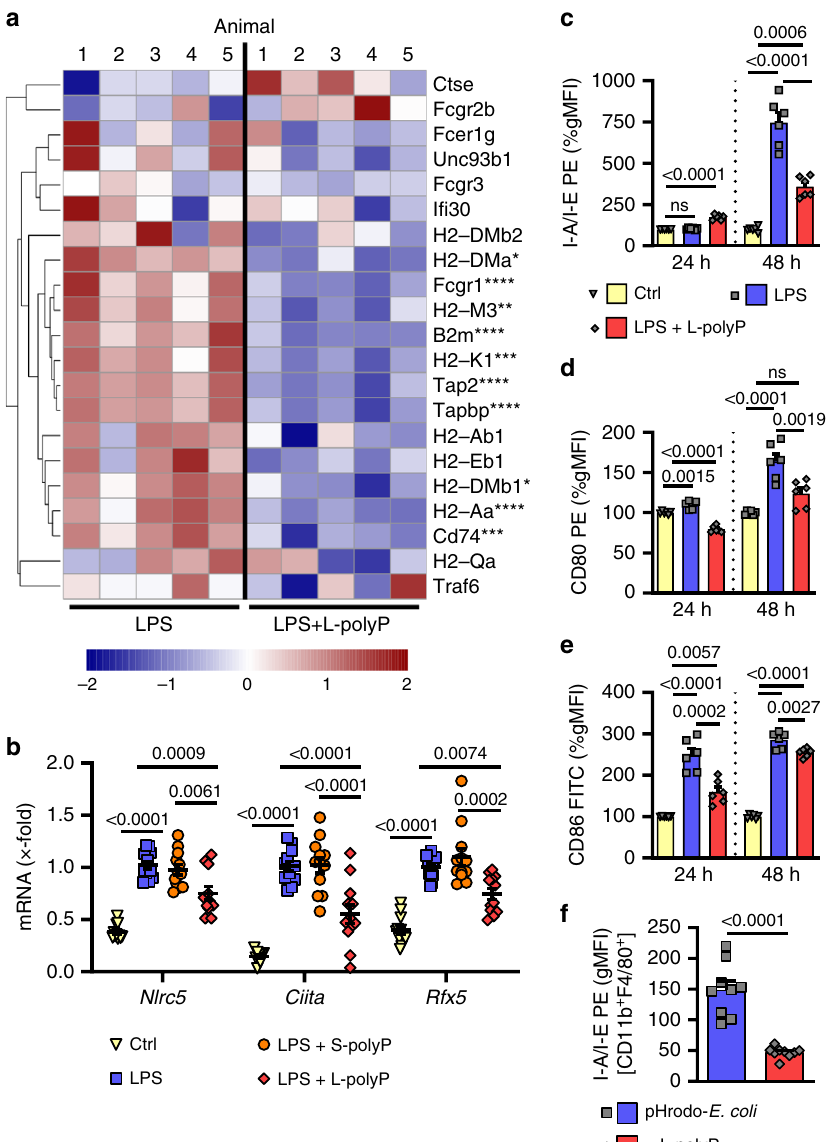
Fig. 5 Interference of polyphosphates with MHCII antigen presentation. a Heatmap of normalized expression ( Z -score from − 2/blue to + 2/red) of genes associated with antigen processing and presentation of exogenous peptide antigen (GO:0002478) comparing LPS alone to its combination with long-chain polyphosphates (L-polyP), n = 5/group, RNA-seq. Statistical signi fi cances of gene expressions are marked by asterisks (displaying the adjusted p value after DESeq2 analysis). b RT-qPCR of MHCI/II associated transcription factors Nlrc5 , Ciita , and Rfx5 in macrophages incubated with LPS ± S-/L- polyP, 12 h. c – e Normalized gMFI of MHCII molecules I-A/I-E ( c ) and costimulatory proteins CD80 ( d ) and CD86 ( e ) on CD11b + F4/80 + macrophages after LPS ± L-polyP, 24 and 48 h, fl ow cytometry. f MHCII (I-A/I-E) surface expression on CD11b + F4/80 + peritoneal macrophages 24 h after intraperitoneal pHrodo- E. coli ± L-polyP, fl ow cytometry ( n = 9 mice/group). Data are expressed as mean ± s.e.m. a Wald test, b – e one-way ANOVA, f two- sided t test, n = 10 − 12 samples/group ( b ) or n = 6 samples/group ( c – e ) examined over three independent experiments, ** p < 0.01, *** p < 0.001, **** p < 0.0001, ns not signi fi cant ( p > a speci fi c pathogen-free environment. Germ-free and monocolonized Swiss Web- ster mice were housed in sterile fl exible fi lm isolators 50,51 . Escherichia coli peritoneal infection . Escherichia coli strains (MG1655 and Δ ppk / MJG224) were described and characterized before 14 . An overnight culture of bacteria